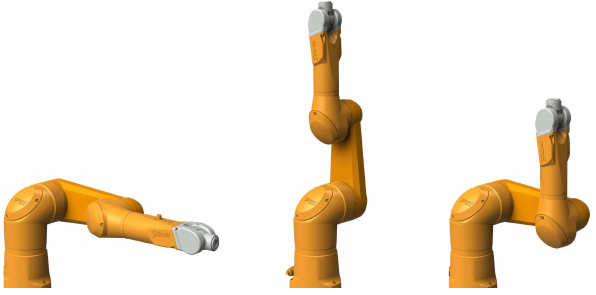
Figure 6. Poses for the FRM calculation represented by q P 1, q P 2 and q P 3 from left to right